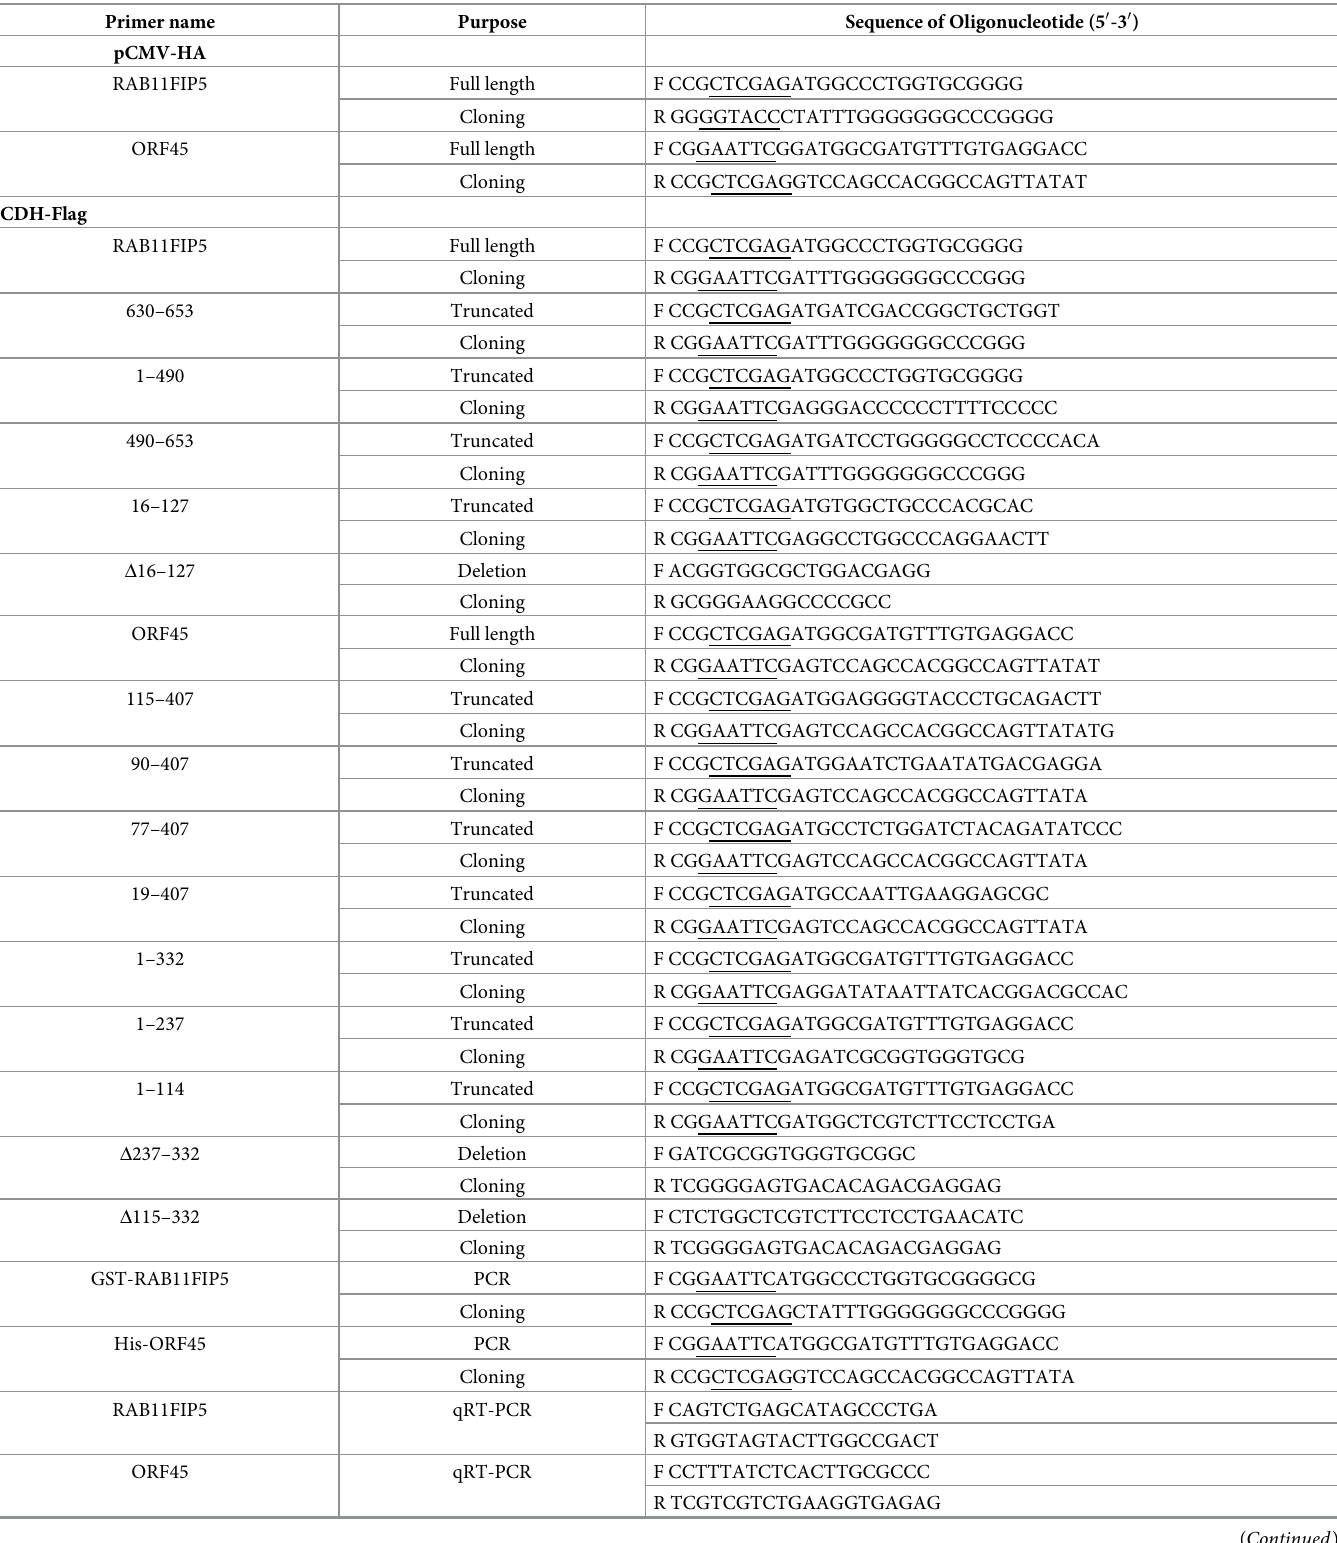
Table 1. Primers used in this